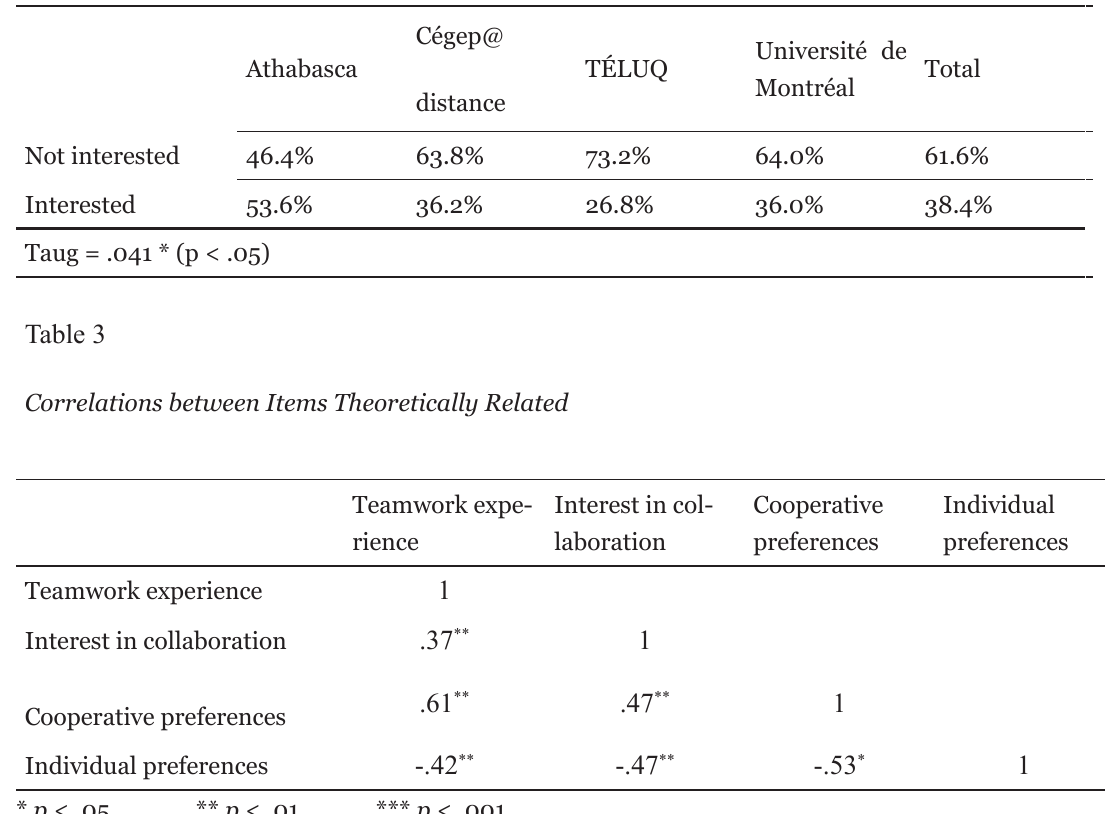
Interest in Collaboration with Peers by Institution